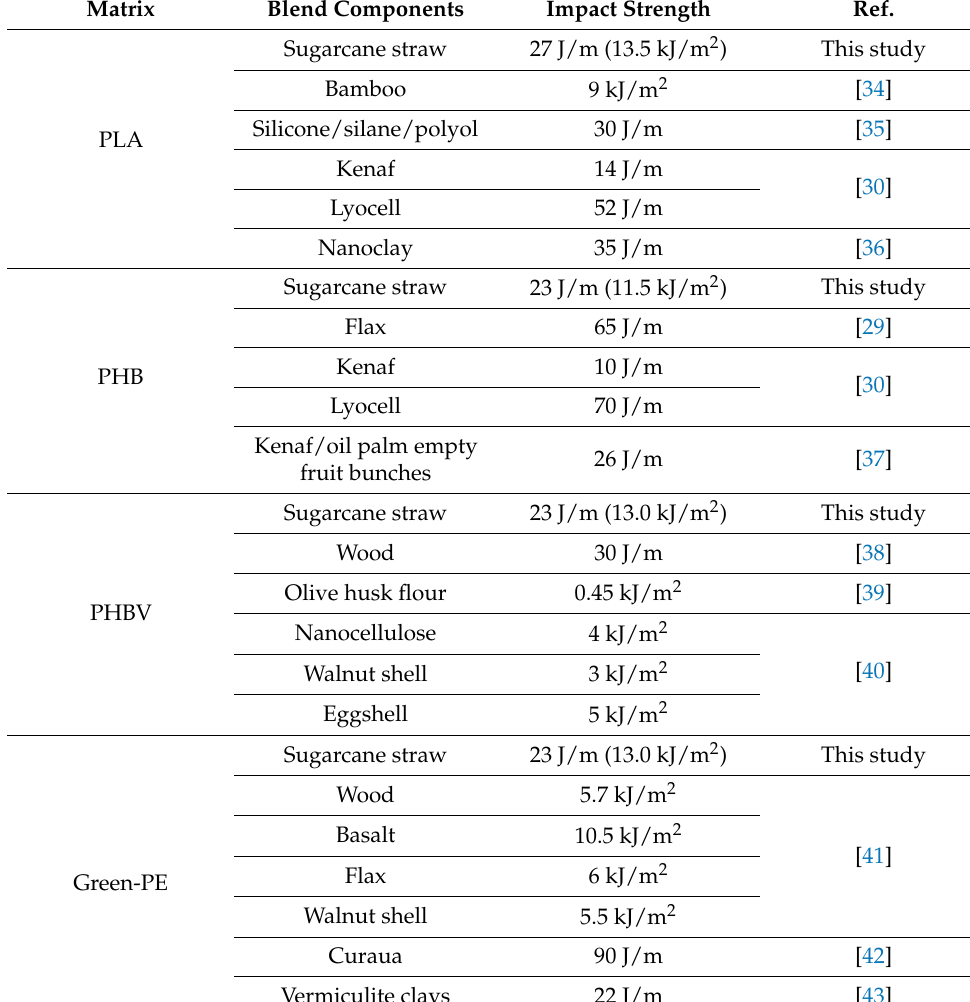
Table 2. Impact strength of different composite materials using the studied